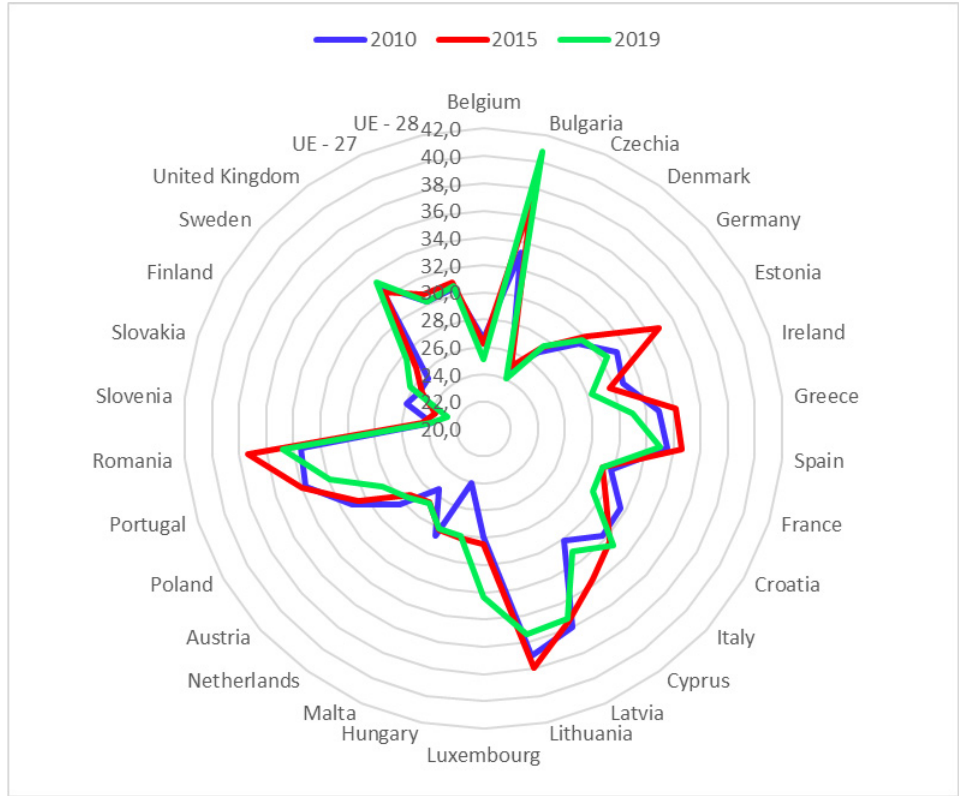
Figure 3. Evolution of the concentration of disposable income within the EU countries (measured by the Gini Index). Source: Prepared by authors based on Eurostat.